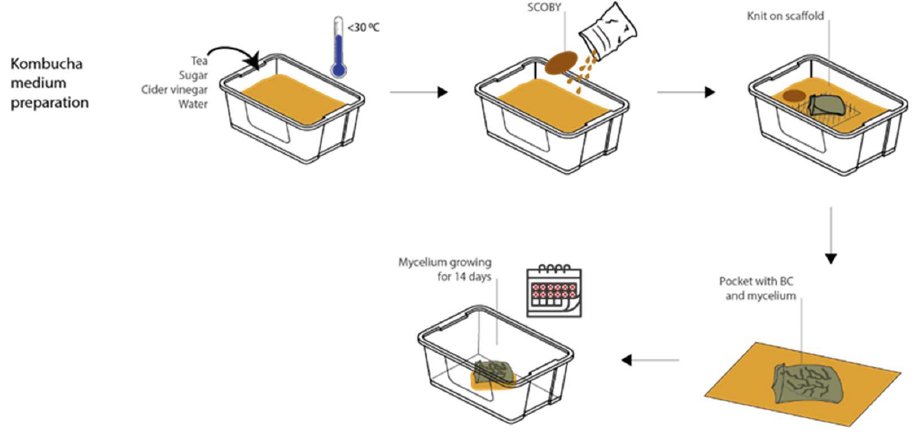
Figure 3. ( a ) The knitted pocket being placed inside the kombucha culture on top of the acrylic scaffold with the top half being lifted. ( b ) Pocket filled with pre-inoculated mycelium substrate and BC folded in 9 layers underneath (image credit: authors).